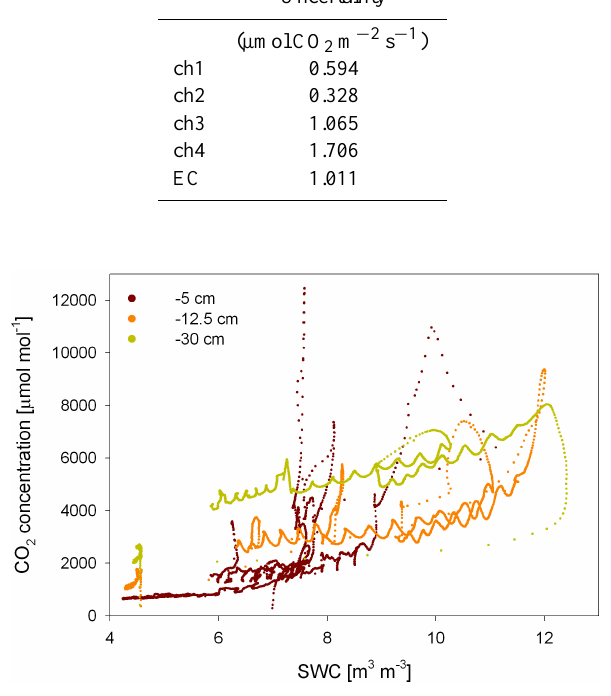
Fig. 5. Dependence of CO 2 concentrations on volumetric soil wa- ter content at three measurement depths during the summer of 2009. Diurnal cycles (probably due to daily temperature changes) and oc- casional peaks of CO 2 concentration (after rain events) are shown superposed on the relationship.